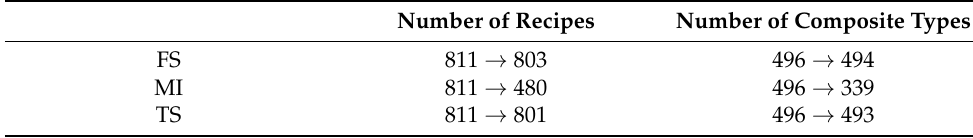
Table 2. Amount of data for the studied physical properties.